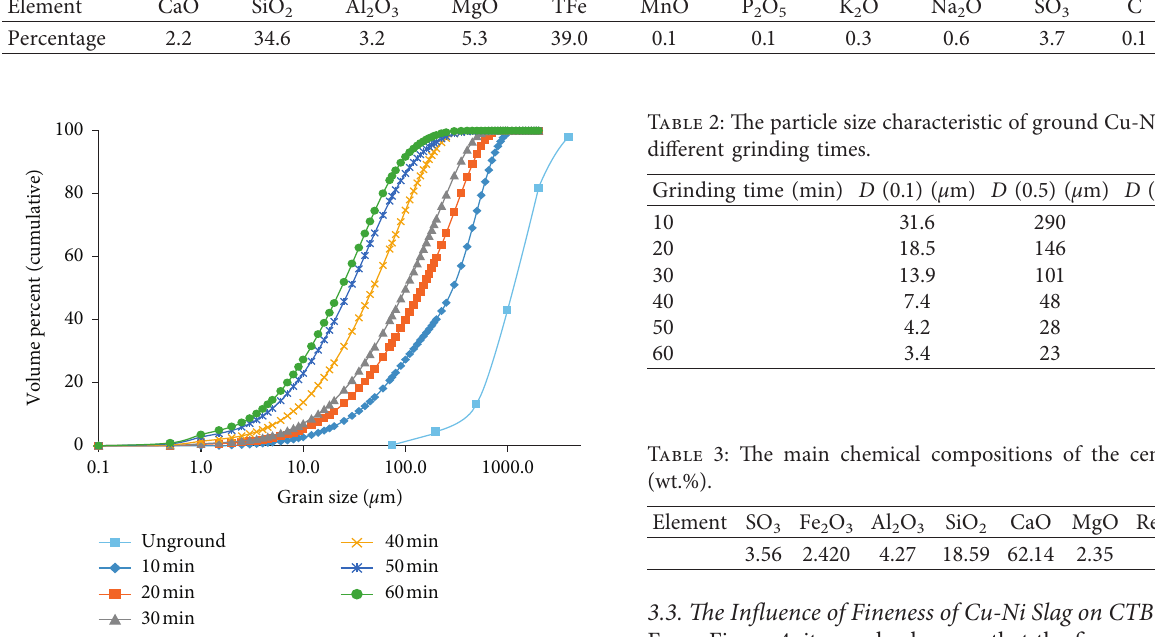
Figure 1: PSD of unground and ground Cu-Ni slag.